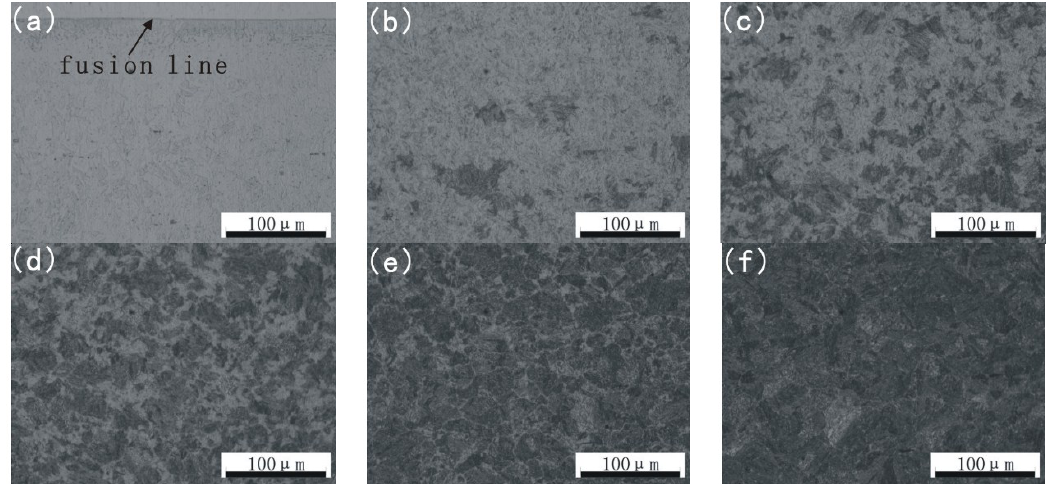
Figure 2. Optical microscope (OM) image of base metal and HAZ distance from fusion line ( a ) 0–0.2 mm; ( b ) 0.75–1 mm; ( c ) 1.25–1.5 mm; ( d ) 1.75–2 mm; ( e ) 2.25–2.5 mm; ( f ) base